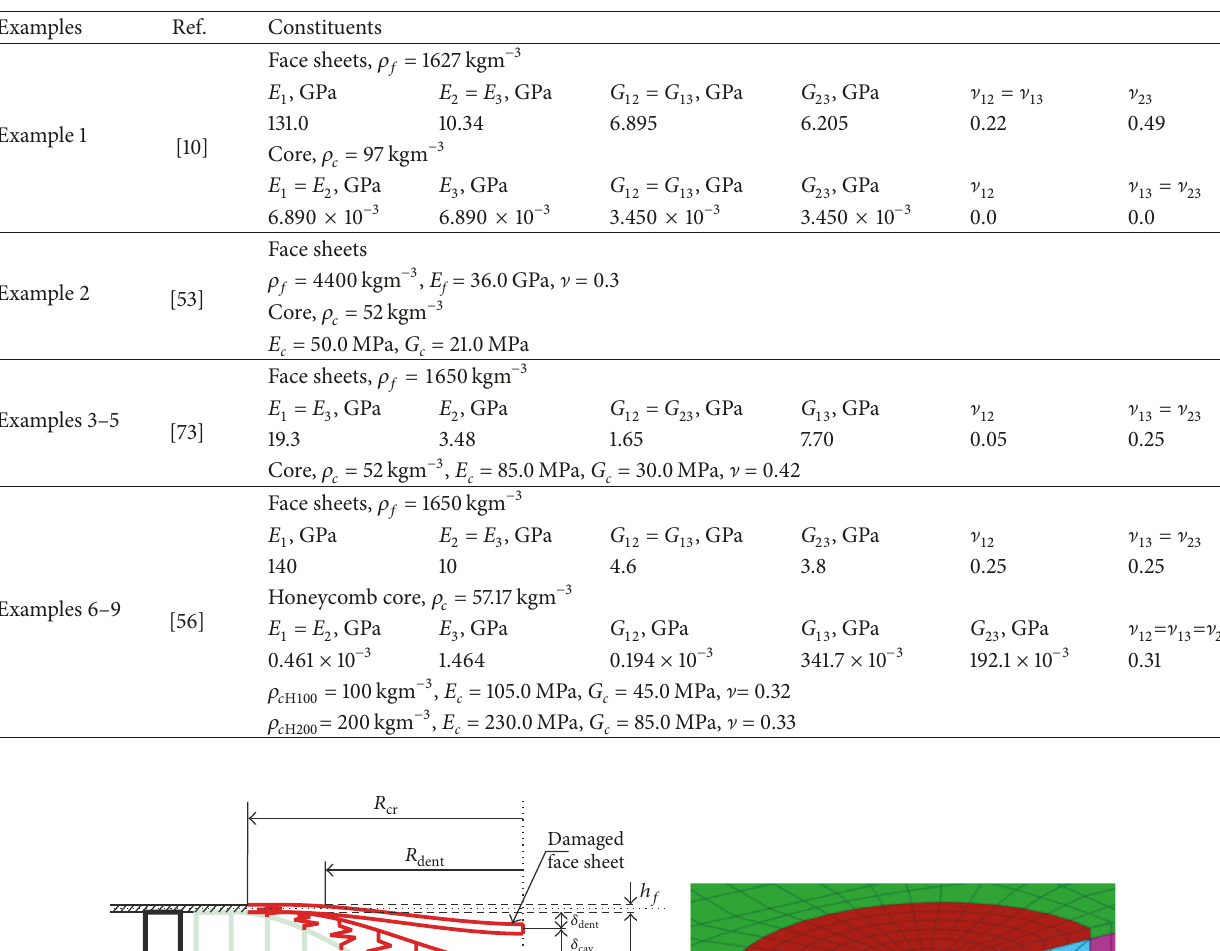
Table 2: Material properties of sandwich panels used in the calculations.